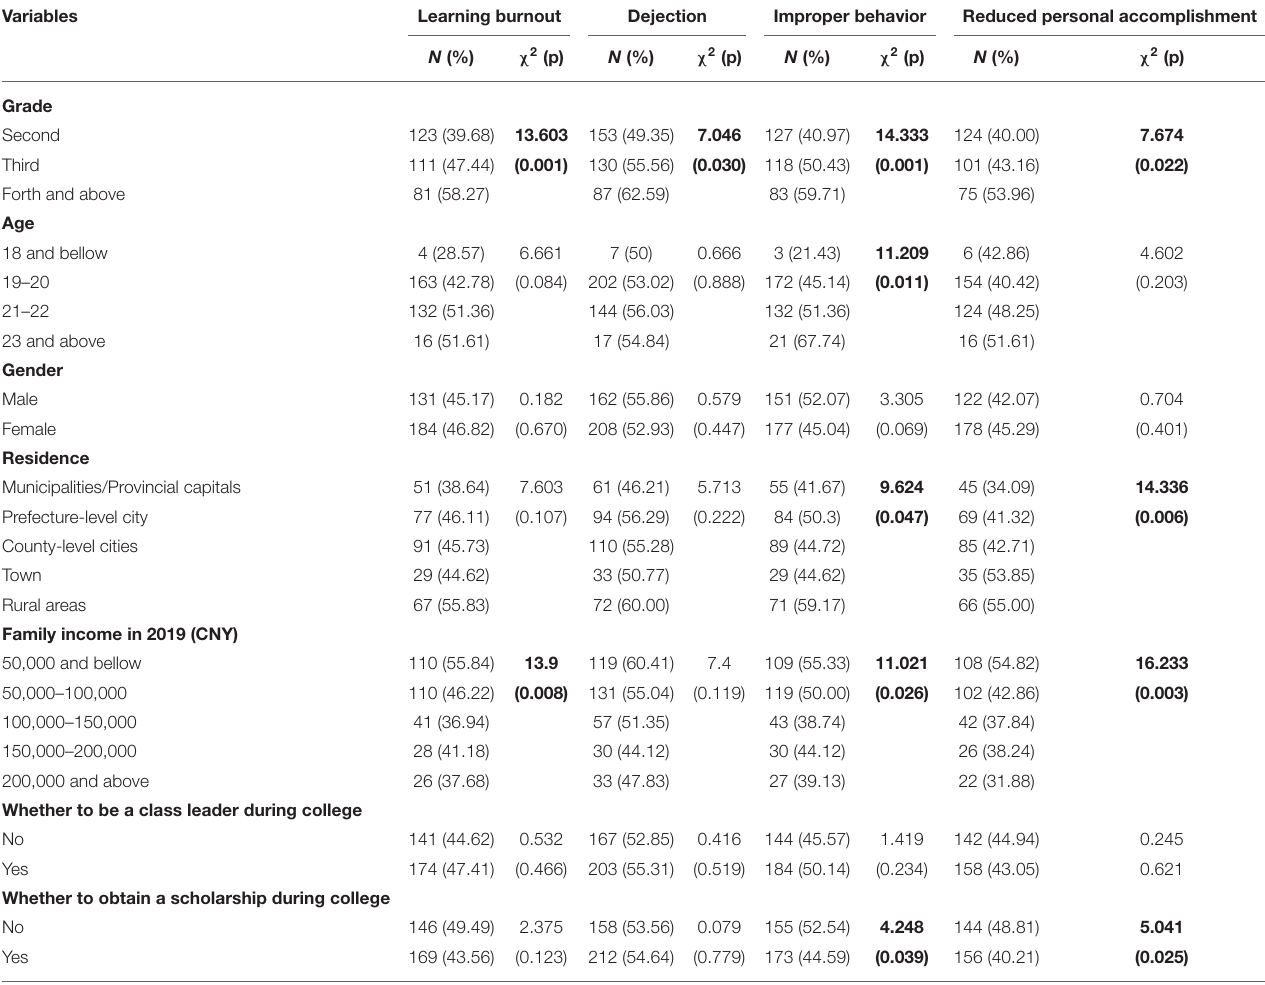
TABLE 2 | Differences in learning burnout and its subscales by demographic